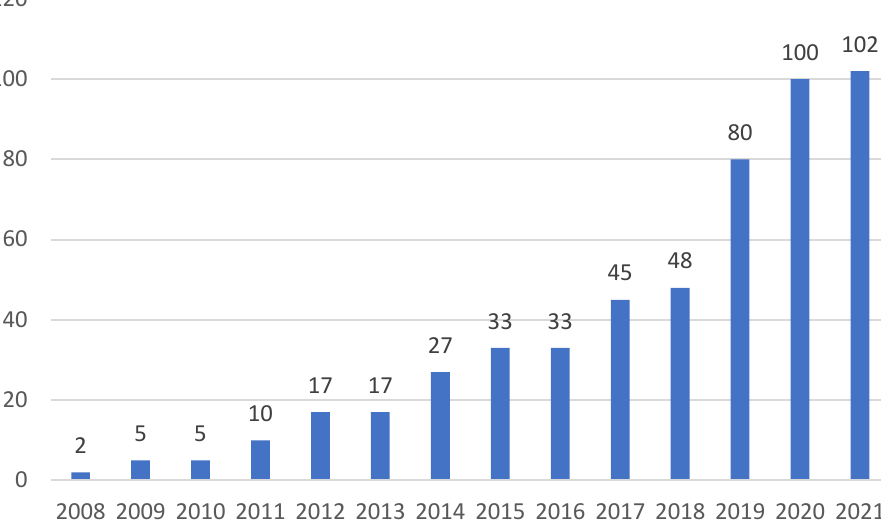
Figure 3. Sources of published articles regarding BIM on carbon emissions for sustainable buildings from 2008 to 2021 (14 years) in WoS (generated by the authors).